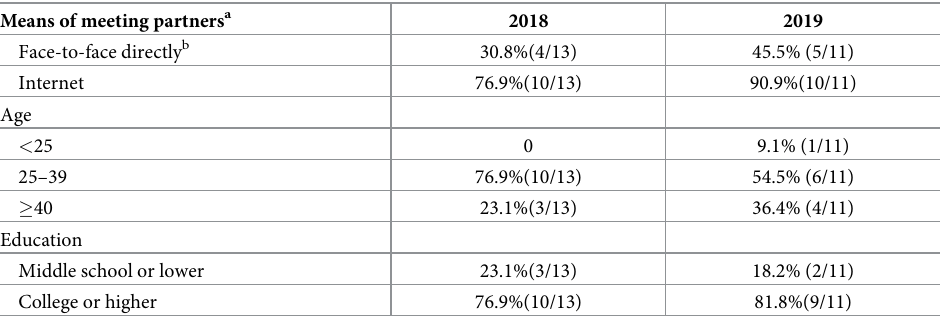
Table 1. Demographic composition of the study seeds in 2018 and